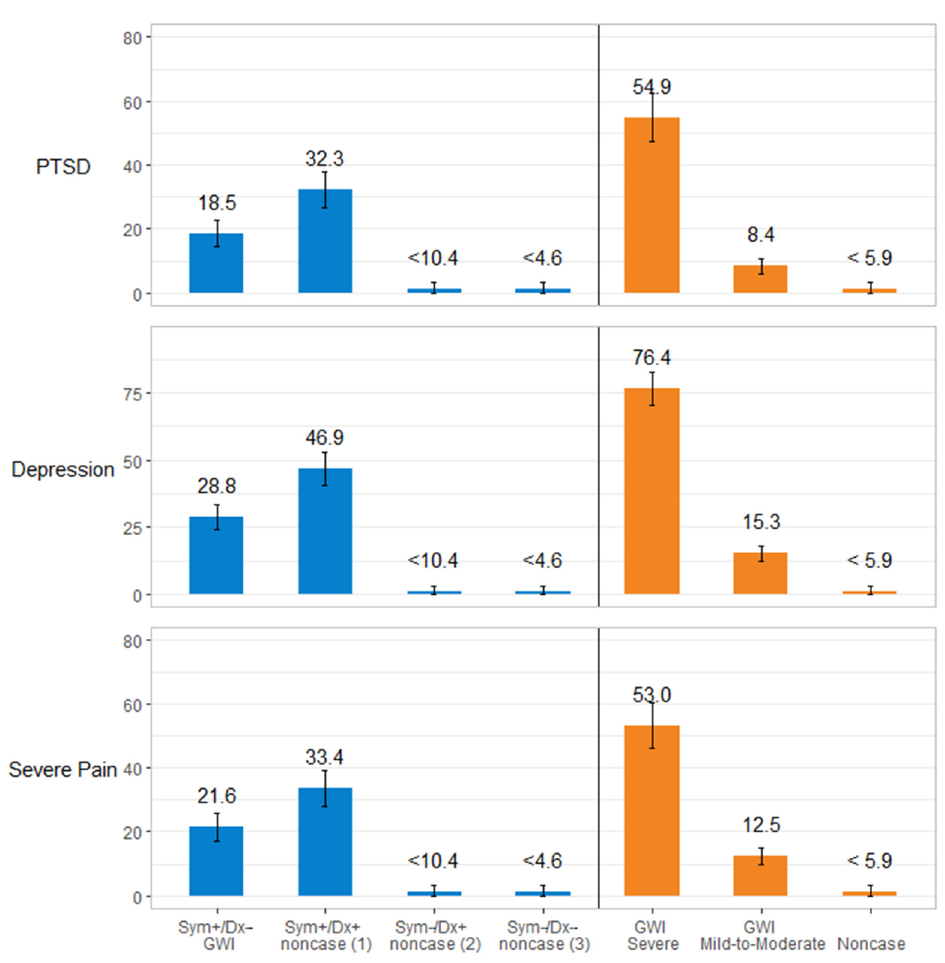
Figure 2. Proportion of GWECB Veterans meeting depression, post-traumatic stress disorder, and severe pain cutpoints by GWI Case Status, adjusted for demographic and characteristics of military service. Note: All values were suppressed due to fewer than ≤ 10) people in cell sizes for (a) KS noncase (2) Sym − /Dx+, (b) KS noncase (3) Sym − /Dx − , and (c) CDC noncases.